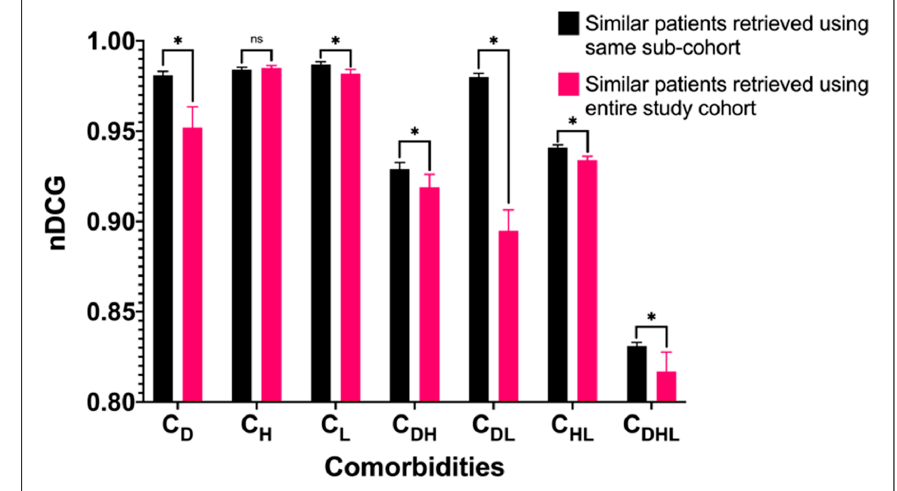
ference (HSD) test.